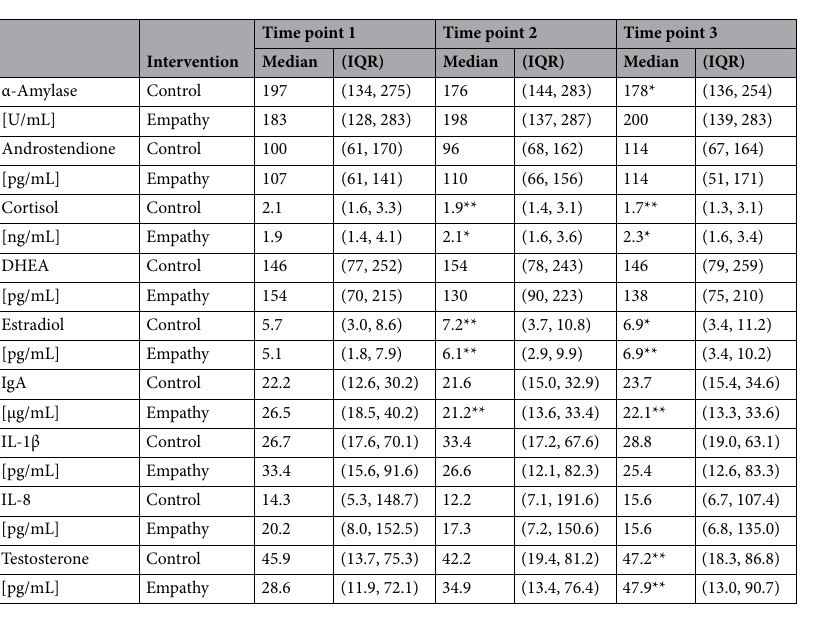
Table 3. Biomarker level pre (time point 1), and post (time points 2 and 3) empathy trigger or control film sequence. Wilcoxon signed-rank Test; * P < 0.05; ** P < 0.01 compared with time point